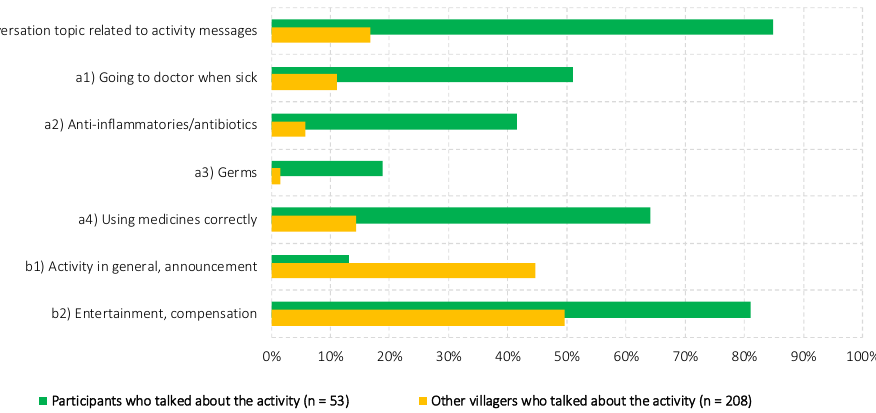
Figure 3. Differences in communicated activity themes across participants and non-participants.